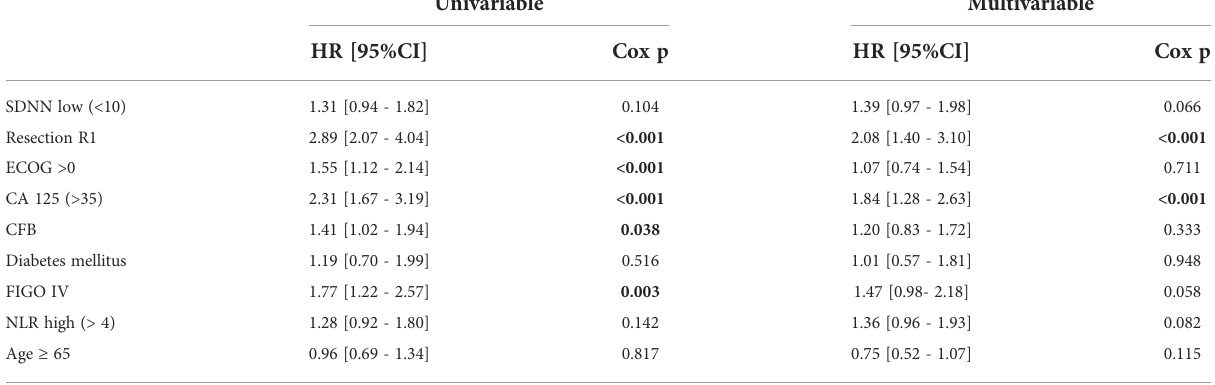
TABLE 4 Univariable and multivariable Cox analysis of progression free